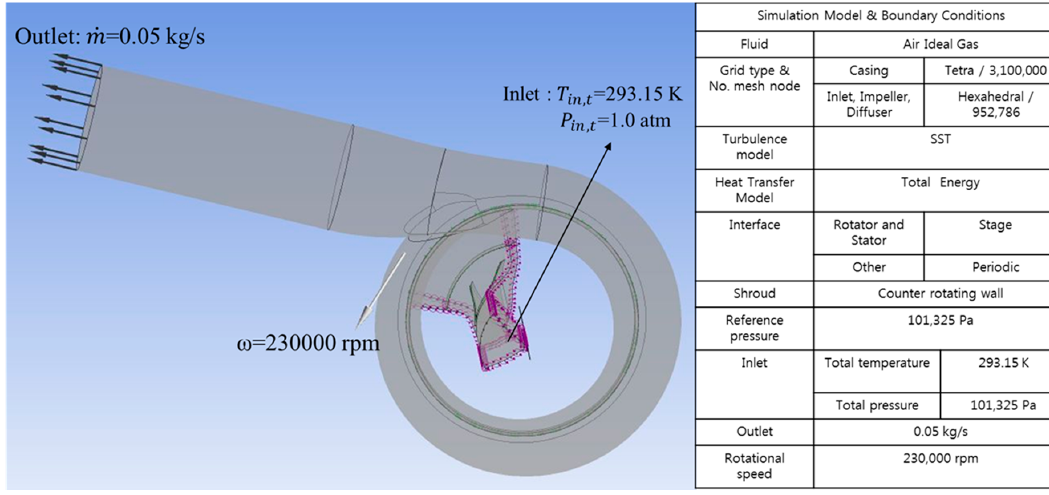
Figure 7. CFD model and boundary conditions.